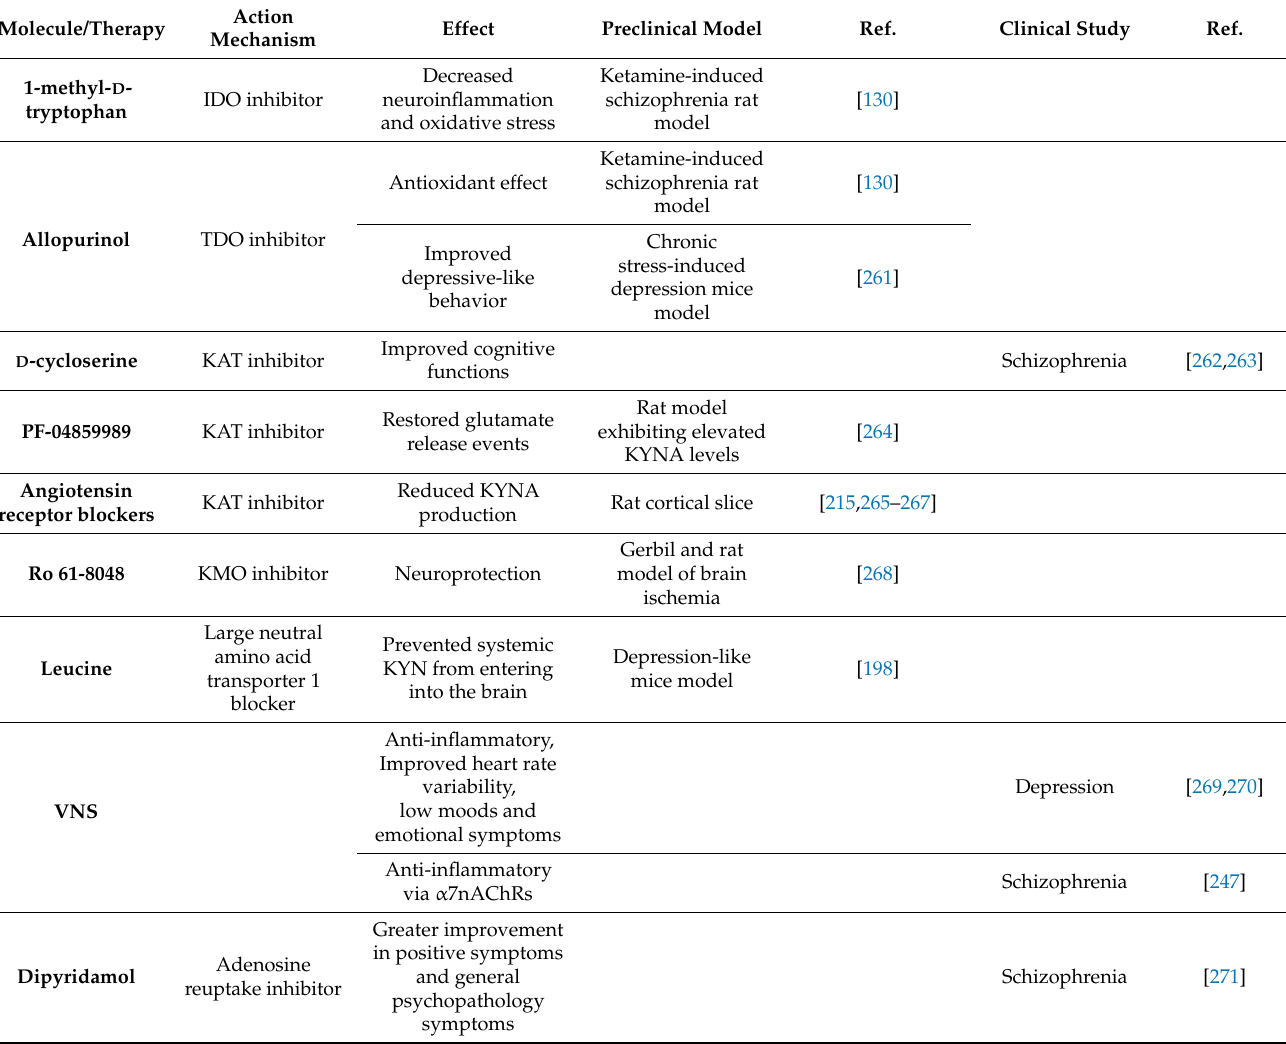
Abbreviation : VNS: vagal nerve